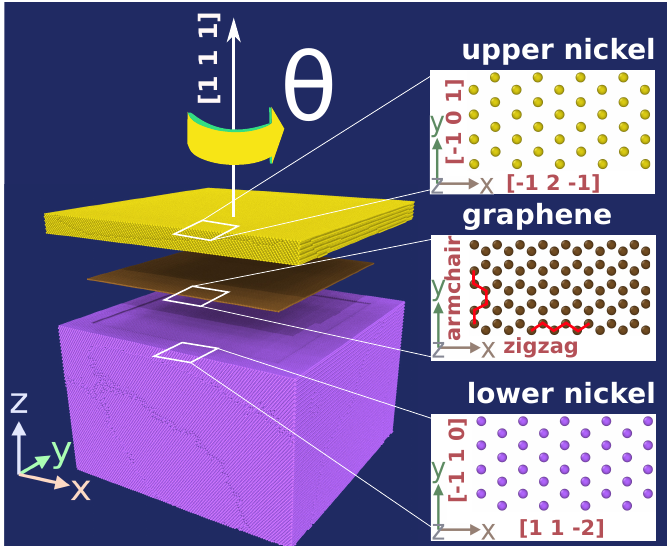
Figure 1. Schematic illustration of the simulation system. Both the lower Ni block (purple) and the upper Ni block (yellow) have a (111) surface; they are separated by a twist grain boundary with twist angle θ . Besides the twist angle of 60 ◦ , we also study 30 ◦ and 0 ◦ , i.e., a single crystal. In the grain boundary, a graphene layer (brown) is